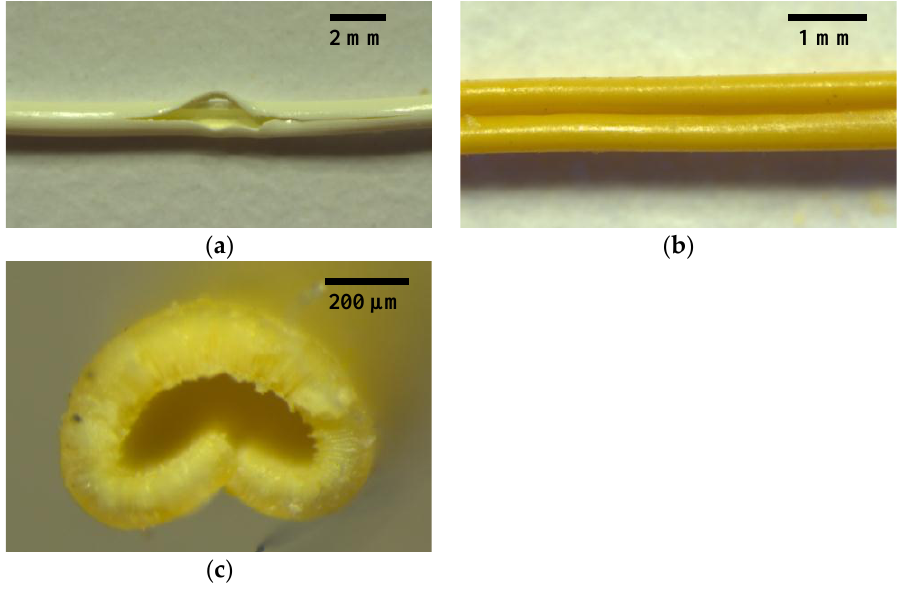
Figure 3. Physical deformations of fiber supports: ( a ) rupture; ( b ) collapse; ( c ) collapse (cross section view).